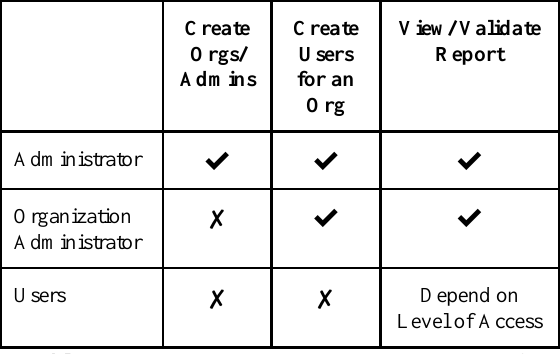
Table 1. User roles in the MASDAN Monitoring Interface